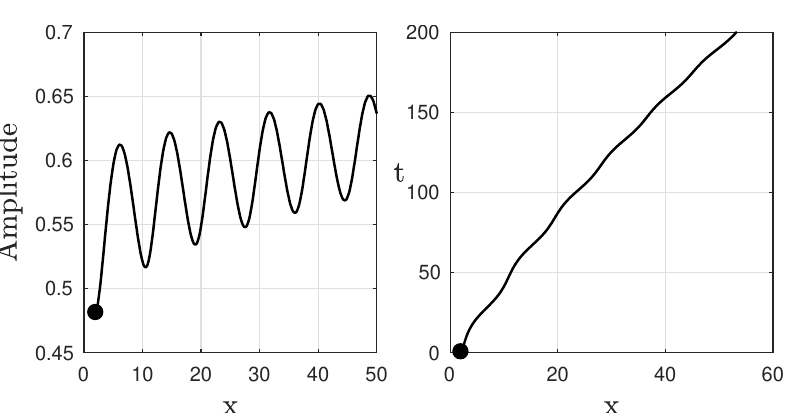
Figure 3. Left : the space amplitude vs. crest position. Right : the crest position along the time. The parameters are the same as in Figure 2 with n =